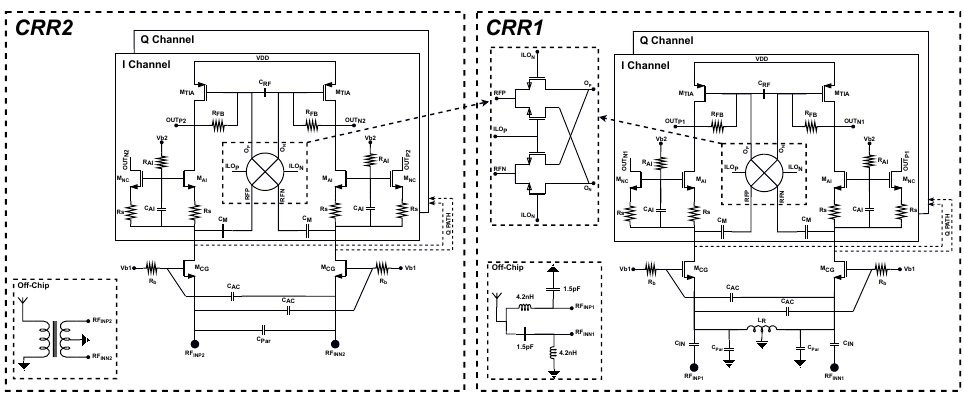
Figure 2. CRR1 proposed in [17] ( right ) and CRR2 proposed in this work ( left